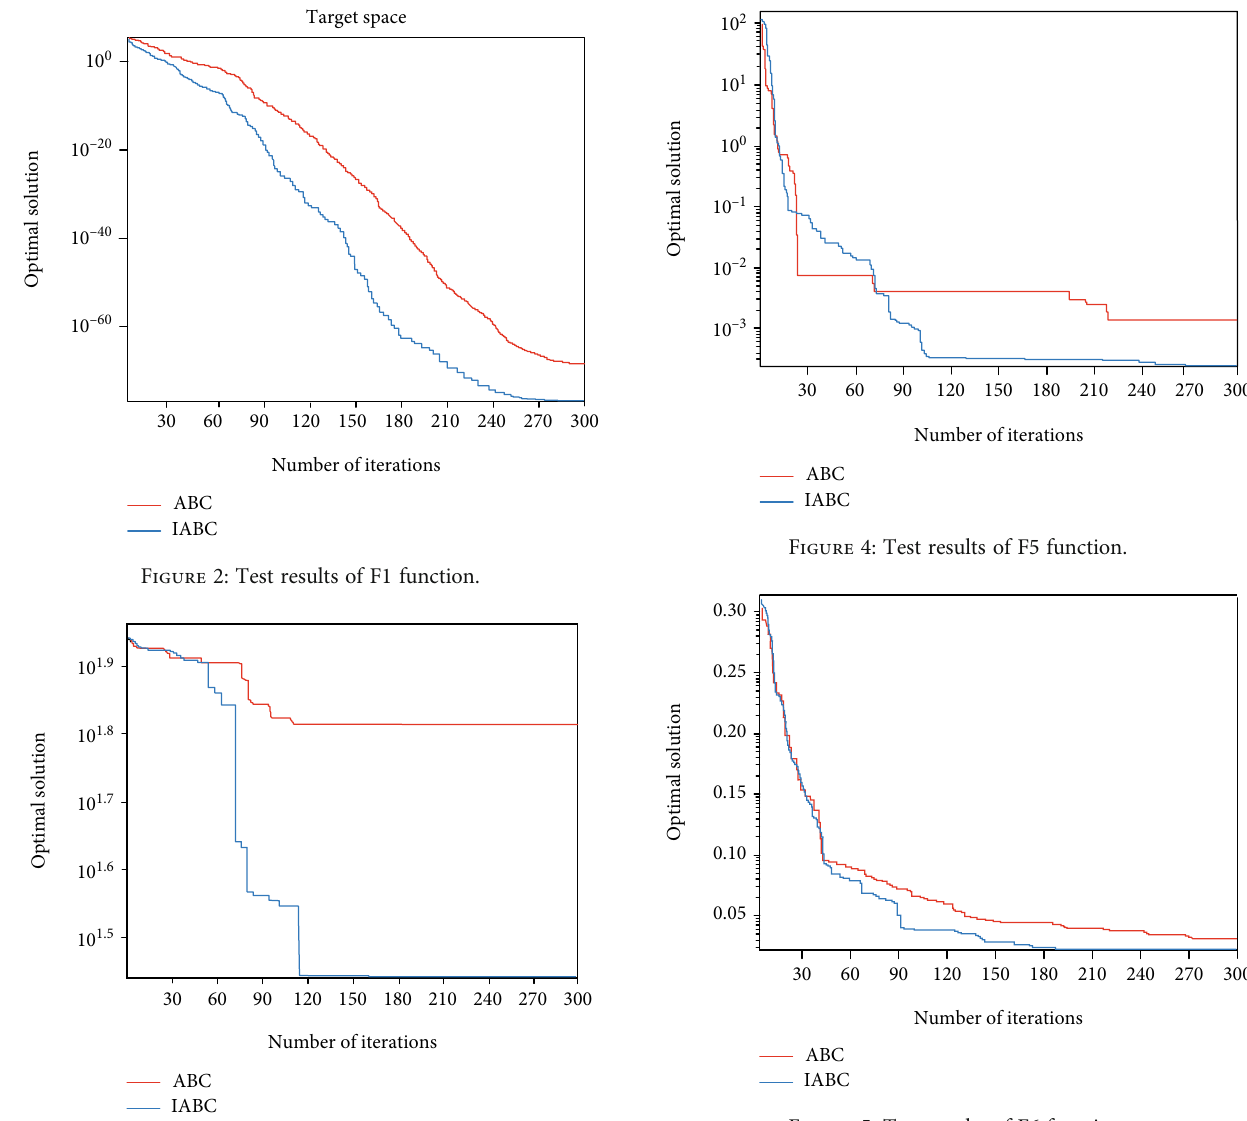
Figure 5: Test results of F6